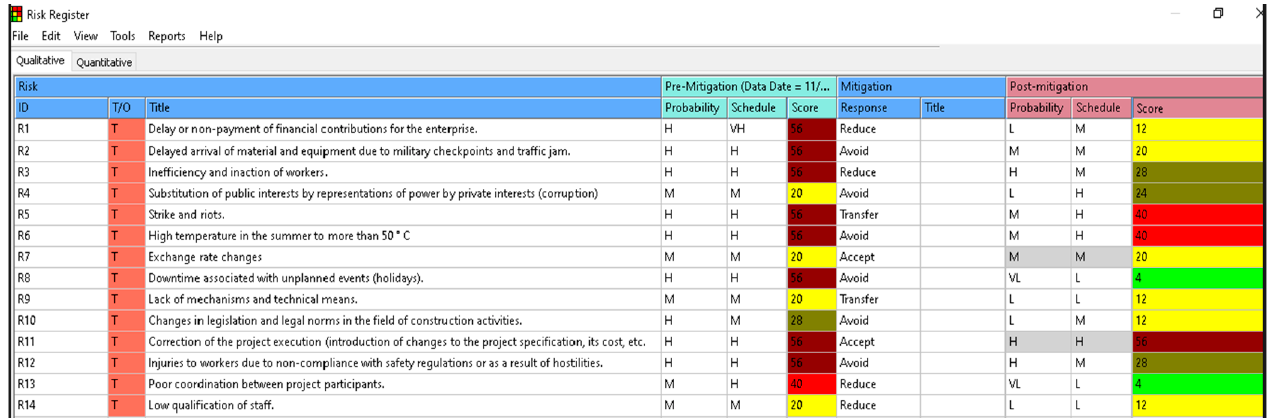
Figure 6. Risk registers for the project schedule.